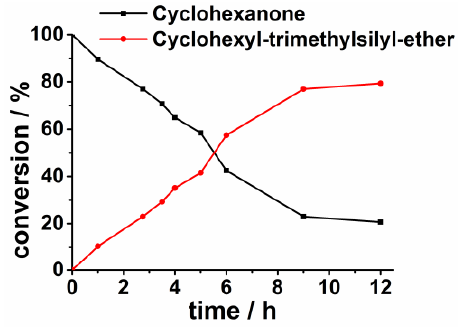
Figure 5. Conversion versus time plot using complex 2á as a